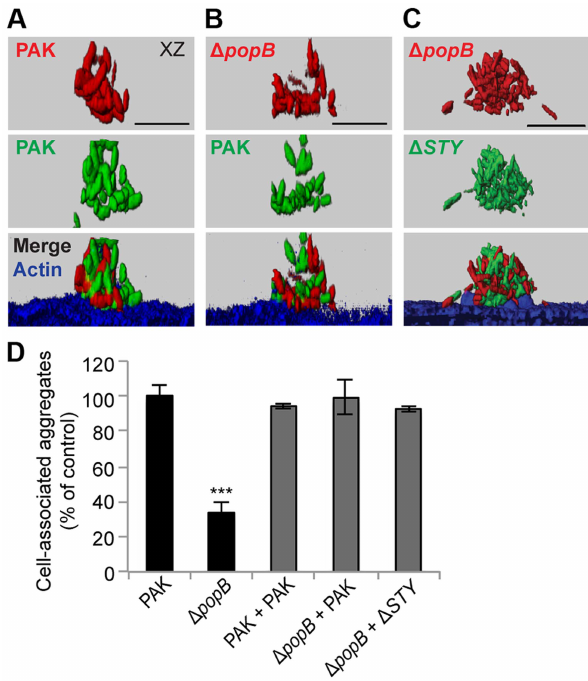
Figure 4. Co-infection with T3SS + bacteria restores cell- associated aggregation in PAK D popB . MDCK cells were co-infected with equal amounts of mCherry-expressing (red) and GFP-expressing bacteria (green), fixed, and stained for actin (blue). Co-infection with (A) PAK-mCherry and PAK-GFP, (B) PAK D popB -mCherry and PAK-GFP, and (C) PAK D popB -mCherry and PAK D STY -GFP resulted in cell-associated aggregates composed equally of both strains of bacteria. Representa- tive 3-D reconstructions from three independent experiments are shown. Scale bars, 10 m m. (D) Cell-associated aggregation after co- infection was quantified using spinning disk confocal microscopy. Shown is the number of aggregates ( $ 10 bacteria) normalized to PAK (n $ 3 independent experiments). Data are mean 6 SEM. ***p , 0.001 compared to PAK. Statistics in Supplemental Statistical Analysis (Text S1).